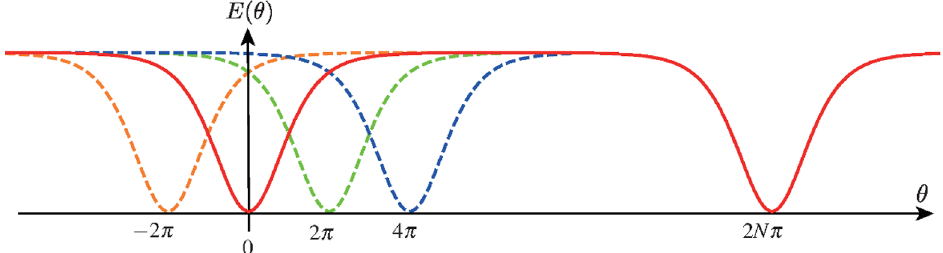
Figure 12 . Schematic picture for the multi-valued vacuum energy for the large N pure Yang-Mills theory, reproduced from ref.